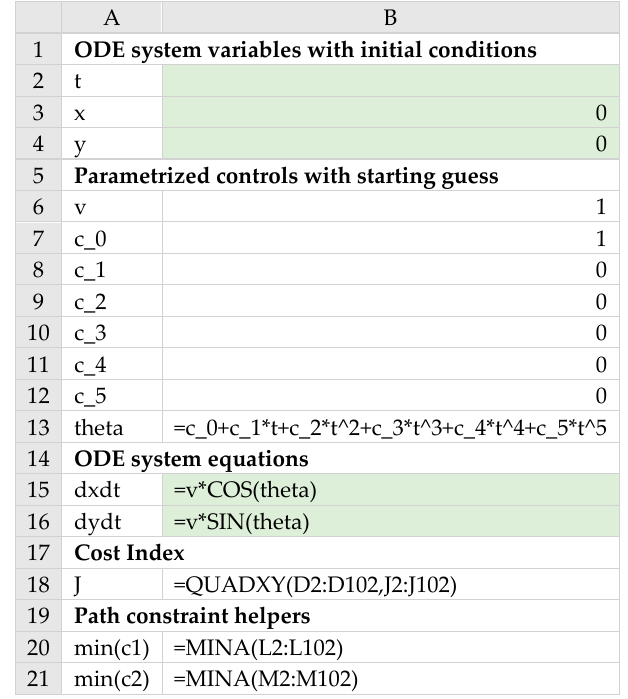
Figure 14 . Spreadsheet parametrized model for problem 3.3. The colored ranges are inputs for IVSOLVE formula (24).